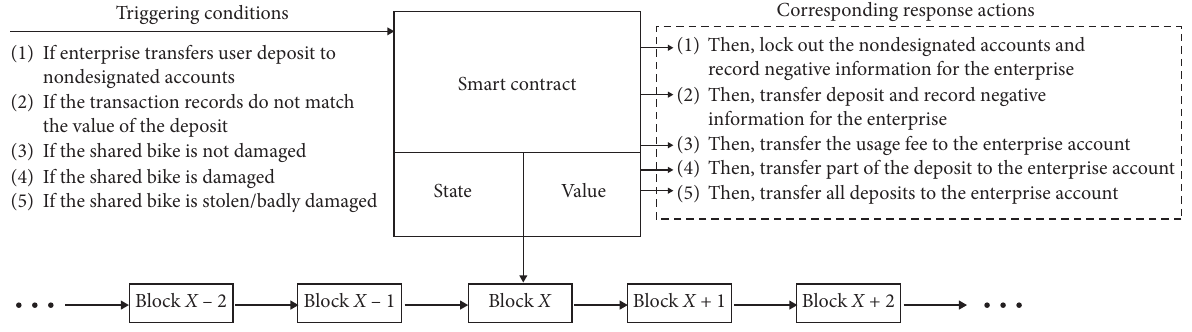
Figure 6: Operational mechanism of the smart contract. Table 1: Basic symbols of the deposit management system for shared